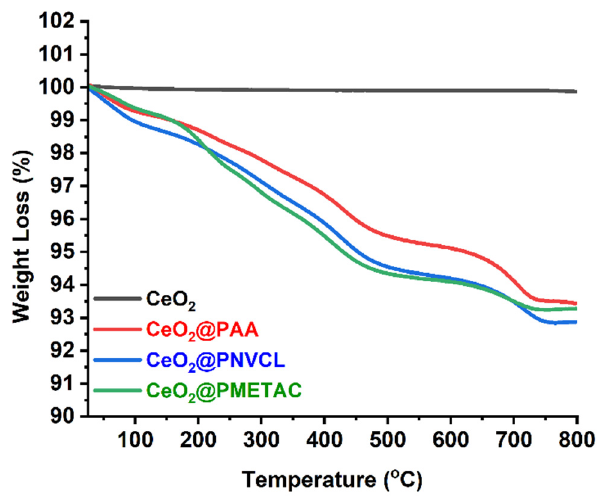
Figure 6. TGA results of the CeO 2 and CeO 2 @polymers.